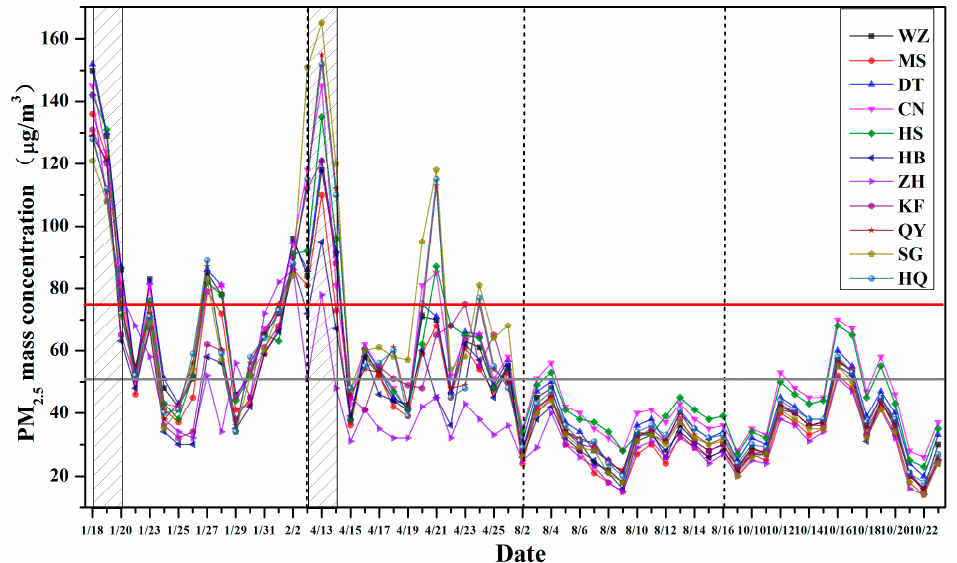
Figure 2. Fine particulate matter (PM 2.5 ) mass concentrations of 11 sites (grey solid line represents average concentration (50.7 μ g/m 3 ) of all the 11sites in 2016, red solid line represents National Standard of PM 2.5 , black dashed lines divide four sampling periods, and the shades areas represent the haze periods).